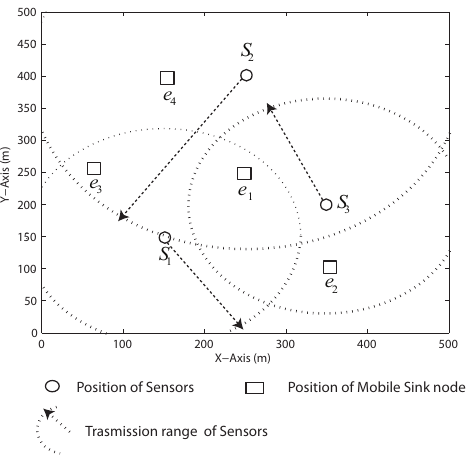
Figure 7. Probable positions of the mobile sink and the default transmission ranges and positions of the sensor